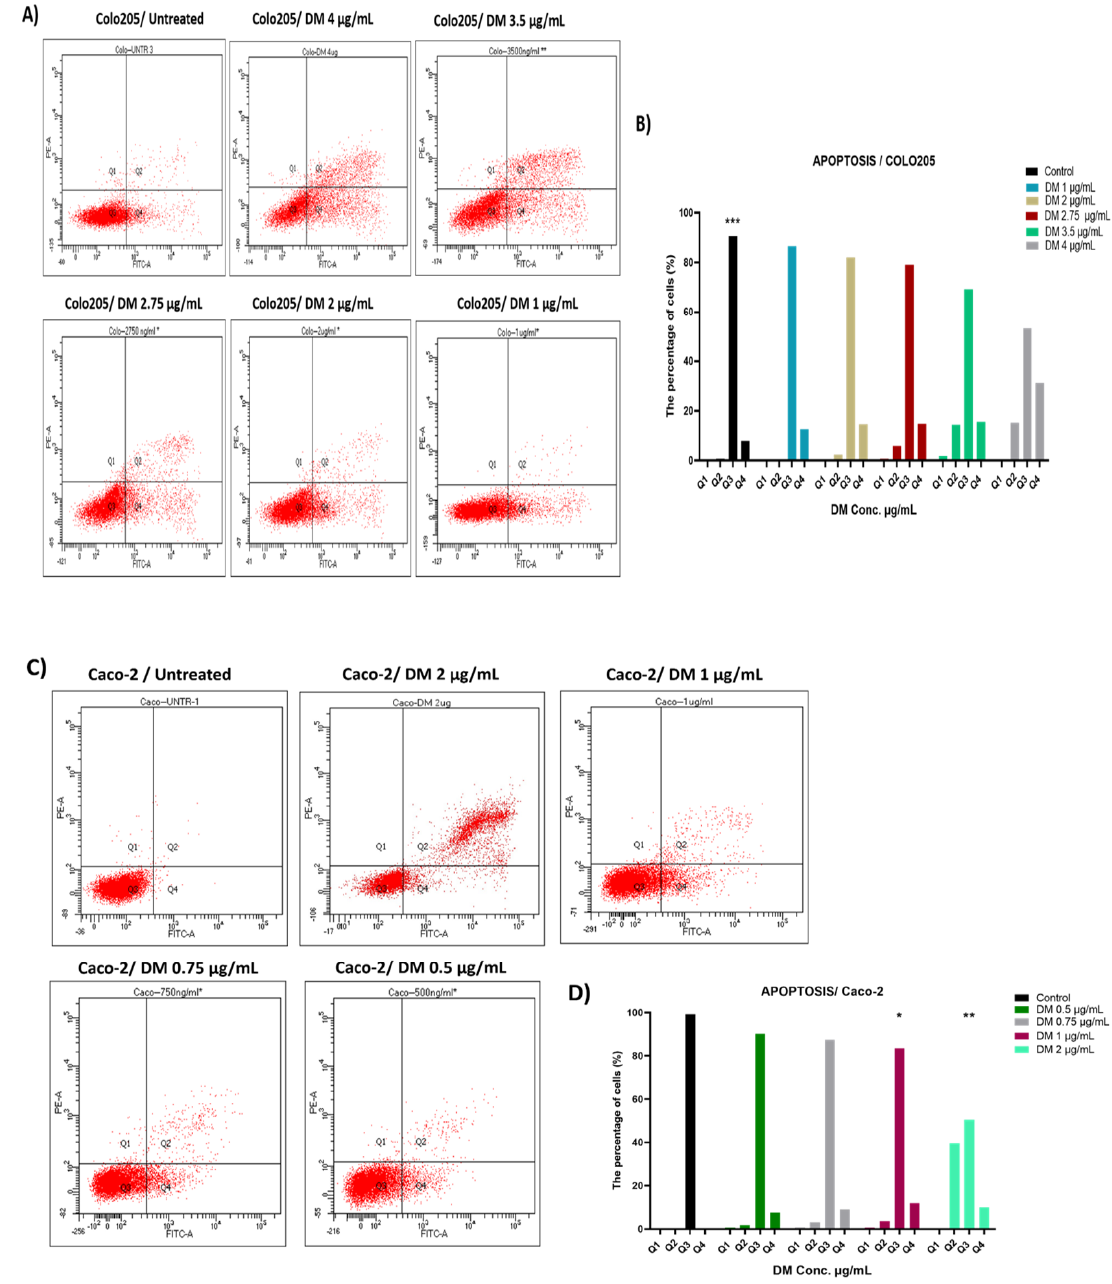
Figure 3. Flow cytometry analysis of D. maritima (DM) bulb extract effect on COLO-205 and Caco-2 cells. (A) Representative flow cytometer plots are presented for the untreated group (control) and DM-treated groups (4 µg/Ml, 3.5 µg/mL, 2.75 µg/mL, 2 µg/mL, 1 µg/mL and 0.5 µg/mL) in COLO205 cells. (B) The bar graph represents the percentage of early and late apoptotic cells detected by flow cytometer from three separate experiments (mean ± SD, n = 3). C) Representative flow cytometery plots are presented for the control group (Untreated) and DM treated groups (2 µg/mL, 1 µg/mL, 0.75 µg/mL, and 0.5 µg/mL) in Caco-2 cells. (D) The bar graph represents the percentage of early and late apoptotic cells detected by flow cytometer from three different individual experiments (mean ± SD, n = 3). ** Significant differences were observed between the DM-treated (2 µg/mL and 1 µg/mL) and untreated control group (p-values ***<0.001, **<0.01 and *<0.05).